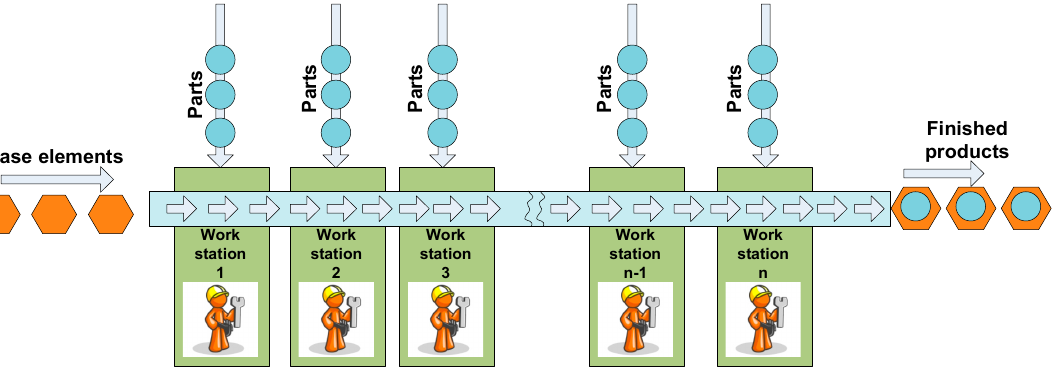
Figure 3. Assembly line structure example.